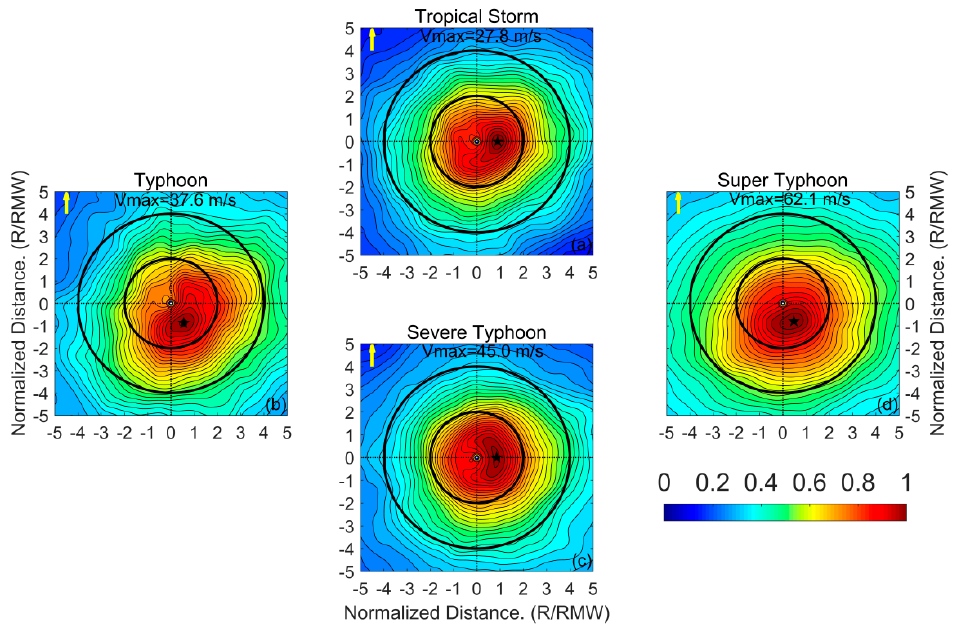
Figure 6. Similar to Figure 5 but in a motion-relative coordinate framework. The yellow arrow indicates the typhoon motion direction. Other details are the